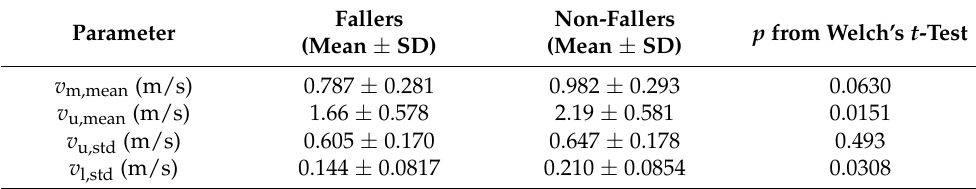
Figure 3. Examples of the measured spectrograms of six participants. ( a – c ): Non-fallers; ( d – f ): Fallers. Table 2. Extracted gait